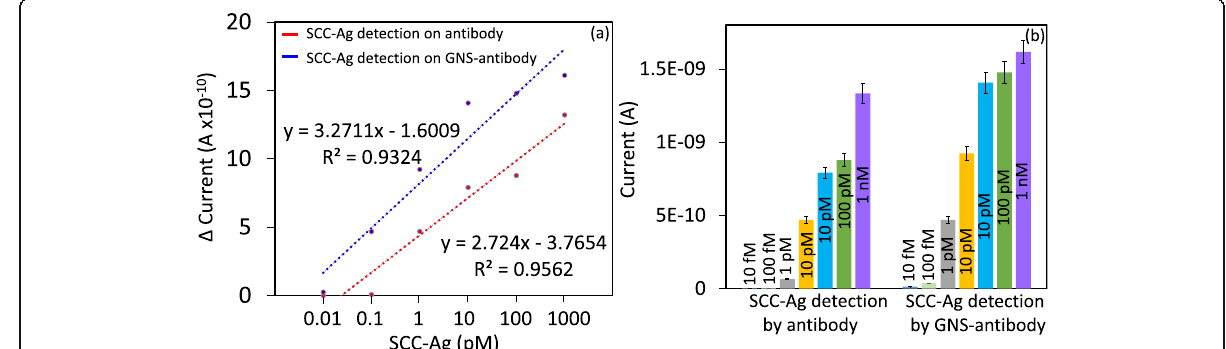
Fig. 6 Comparison of current changes with different concentrations of SCC-Ag on antibody- and GNS antibody-modified surfaces. a Linear regression graph for the limit of detection of SCC-Ag. With antibody (red line) and with GNS antibody (blue line) are displayed. The limit of detection was found as 10 fM with GNS antibody and 100 fM with only antibody. b Current changes with SCC-Ag and antibody interaction. With all the concentrations, a higher level of current changes was found on GNS antibody surface. A linear sweep voltage of 0 to 2 V at 0.01 V step voltage was followed for the measurements. Error bar indicates the averaged values from triplicates ( n = 3) with the standard deviations are in the range of ± 0.1 to 0.15 × 10 − 9 A. The limit of detection (LOD) was considered the lowest concentration of an analyte (from the calibration line